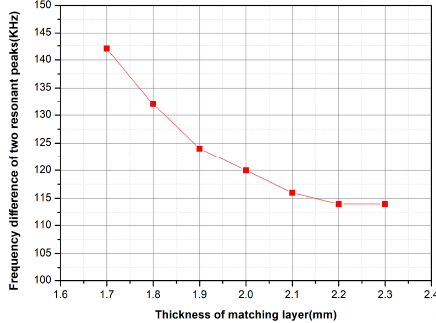
Figure 7. The difference of the resonant peak value of the two vibration modes with different matching layer